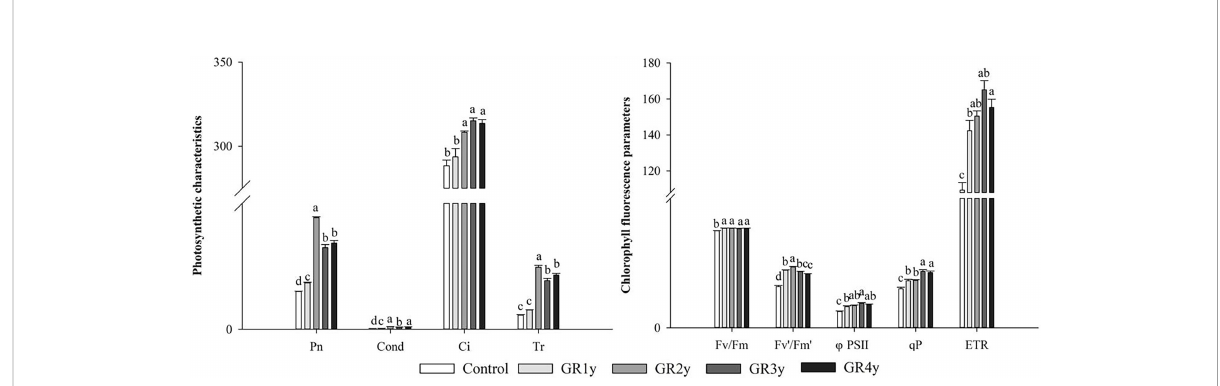
FIGURE 2 Effect of grazing rest during the spring regreening period on the photosynthesis of the dominant grass Elymus nutans Griseb of the degraded alpine meadow vegetation. Bars represent SEs. Common letters above columns indicate no signi fi cant difference at P = .05. GR 1y, GR 2y, GR 3y, and GR 4y mean grazing rest for 1, 2, 3, and 4 years, respectively.